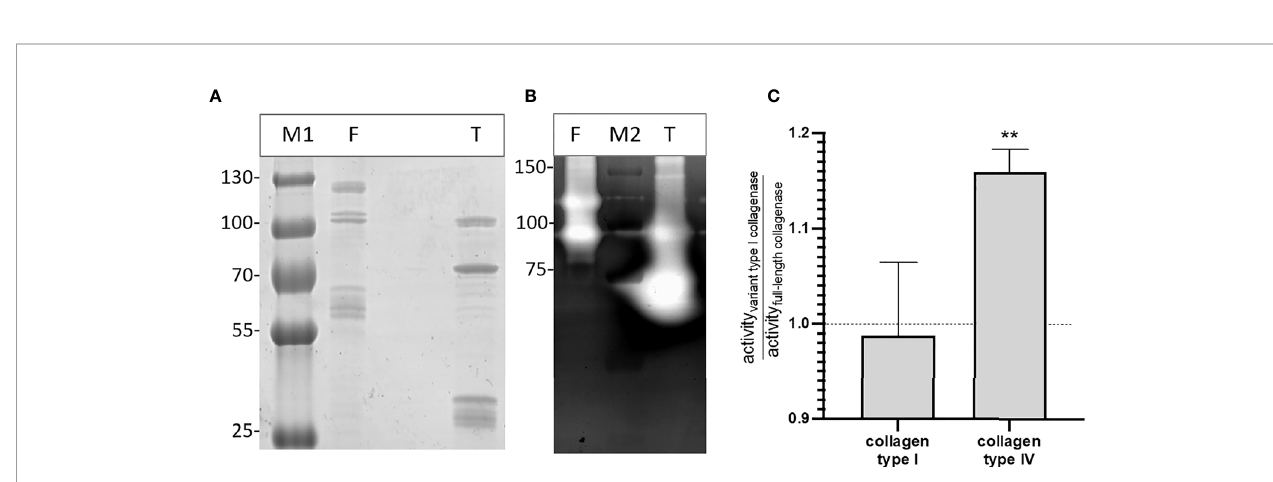
FIGURE 6 | Recombinant full-length and variant type I collagenase have active auto-cleavage products. (A) SDS page and (B) Gelatin zymography of the recombinantly expressed collagenase fragments. F = full-length collagenase, expected fragment 120 kDa; T = Type I variant collagenase, expected fragment 94 kDa; M1= Pageruler plus pre-stained, M2 = Precision Plus protein All blue Pre-stained Protein standard. (C) Substrate-degrading activity of both the full-length collagenase and variant type I collagenase towards collagen type I or collagen type IV was measured using the EnzChek collagenase assay. The bar shows the activity of the variant type I collagenase relative to the full-length collagenase towards each of the tested substrates. Data represents mean ± standard deviations (n=3). One-sample t-tests were performed to evaluate whether the ratios differed signi fi cantly from 1, i.e. the ratio value that corresponds with an equal activity of both collagenase variant I and full-length collagenase. **p ≤